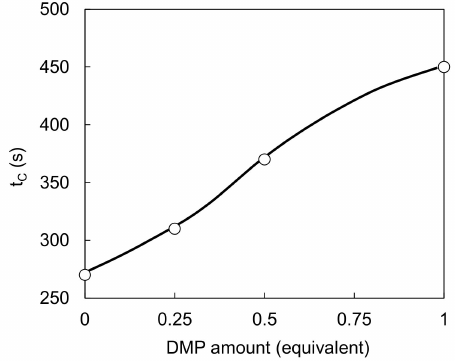
Figure 7. Relationship between DMP amount and t C .